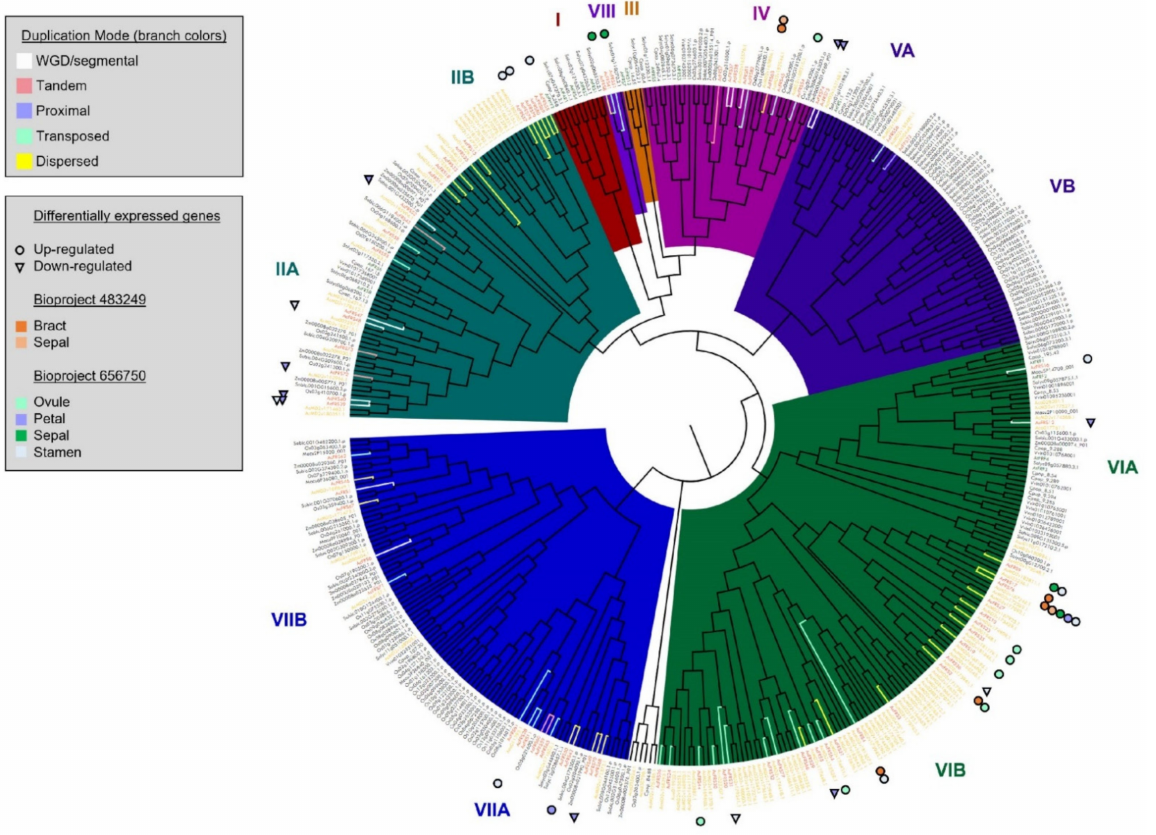
Figure 4. Phylogenetic tree of FRS/FRF genes from MD2 v2, other pineapple genomes (MD2 v1 and F153 v3), and eight non-pineapple species ( A. thaliana , C. papaya , M. acuminata , O. sativa , S. lycopersicum , S. bicolor , V. vinifera , and Z. mays ). Only clades containing FRS/FRF genes from MD2 v2 or Arabidopsis were numbered (Clades I–VIII). Gene names in orange correspond to pineapple MD2 v2,